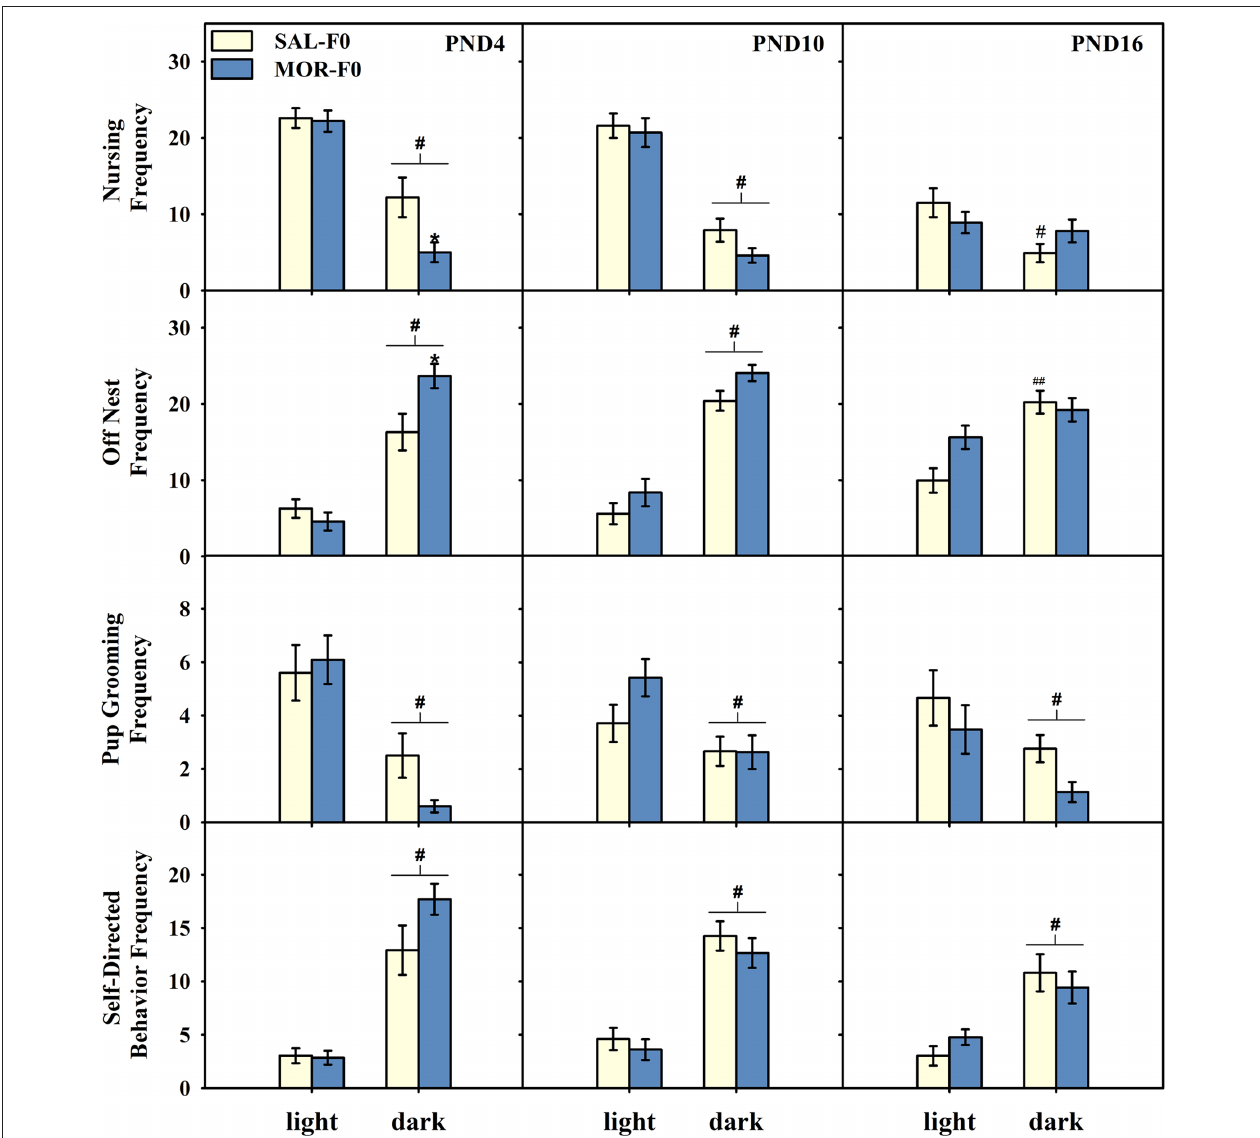
Figure 2 | Mean ( ± SeM) frequency nursing, off nest, pup grooming, or engaged in self-directed behaviors on PND4, 10, and 16. Data collected during the light phase was averaged across three observation periods (0900, 1200, and 1500 hours). Data collected during the dark phase was averaged across two observation periods (0500 and 2000 hours). # p < 0.01 compared to light phase collapsed across maternal adolescent exposure condition. ## p < 0.05 compared to light phase within SAL-F0. * p < 0.02 compared to SAL-F0 females within day. N = 15 SAL-F0; N = 18